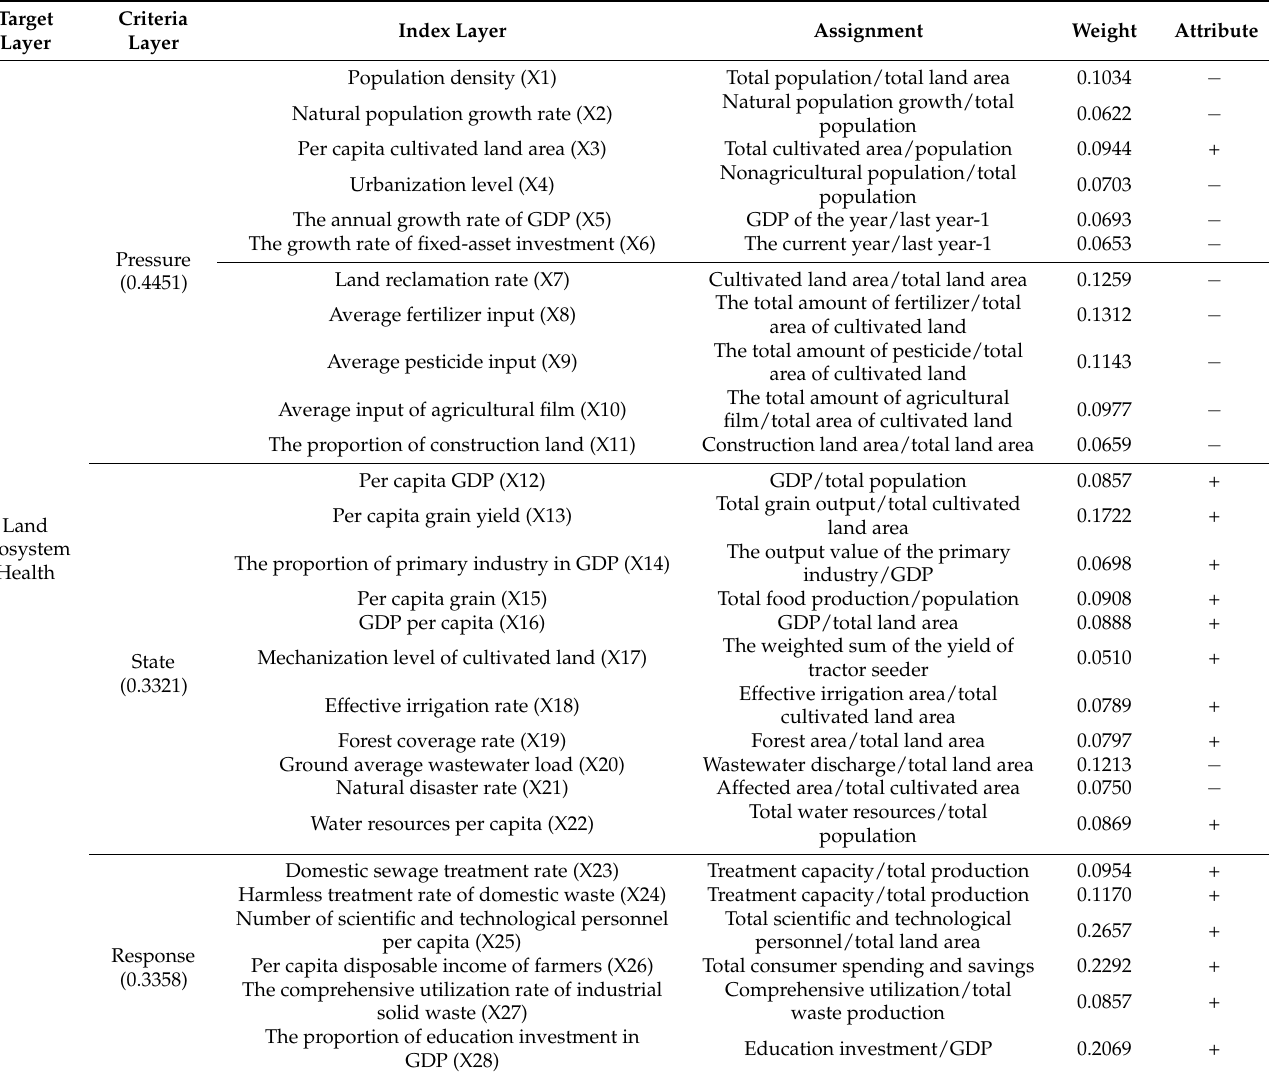
Table 1. TEH evaluation index system for Henan